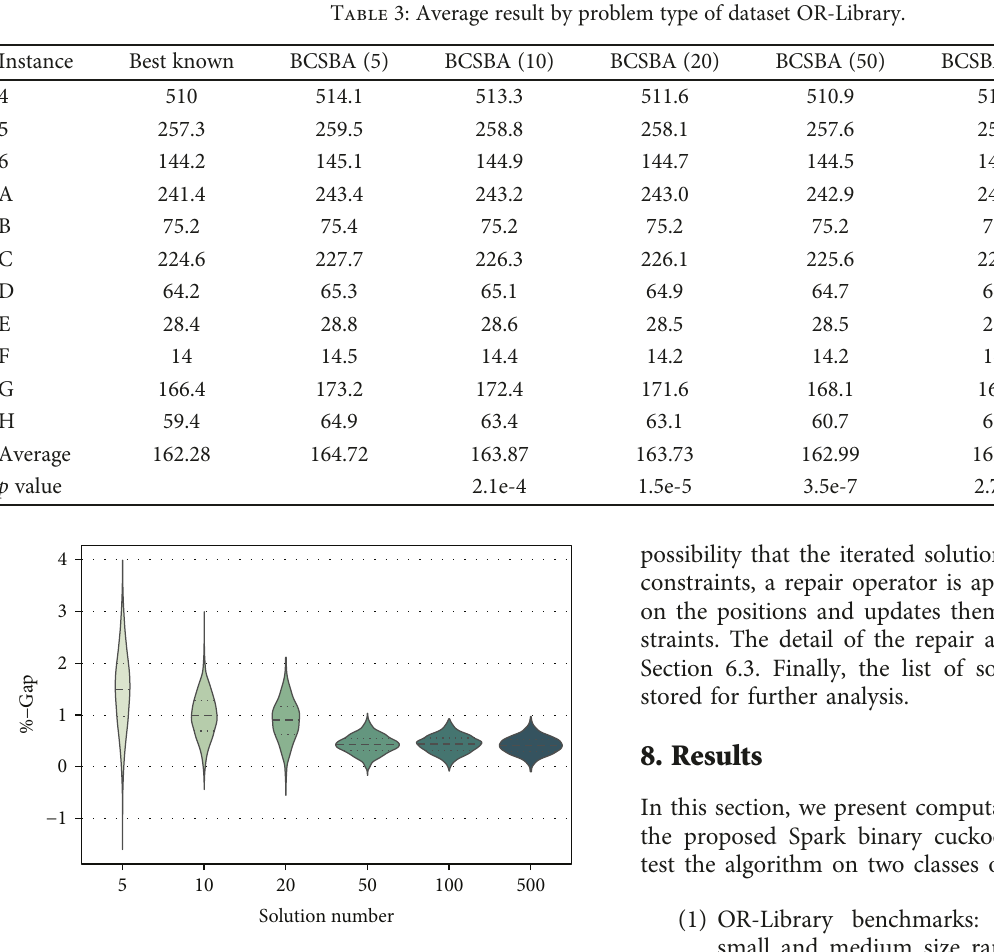
Figure 4: Violin chart of the results quality by solution